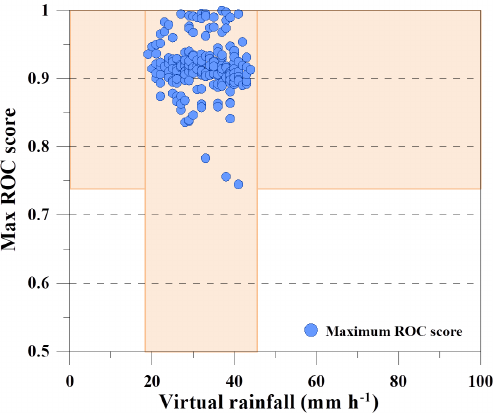
Figure 9. Relationship between maximum ROC and uniform vir- tual rainfall for all the sub-basins. Shaded areas represent the range (maximum to minimum) of virtual rainfall and ROC score.